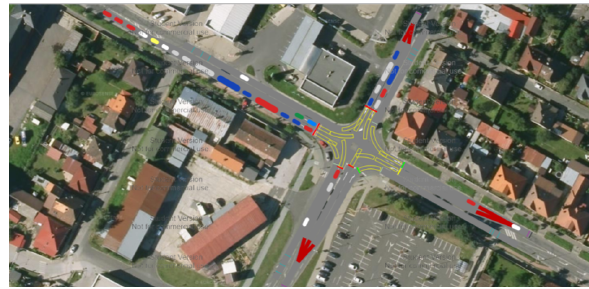
Figure 8: Traflc congestion on the current intersection model